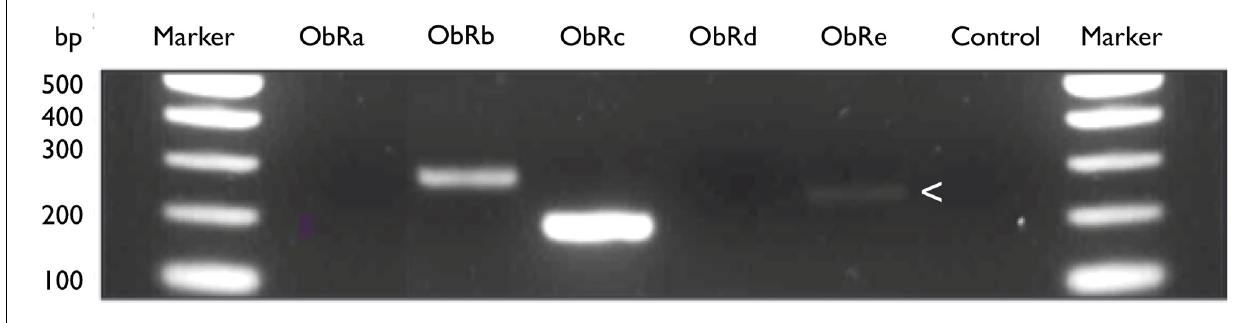
FIGURE 3 | LeptinR isoforms Ob-Rb, Rc, and Re by murine CD4 + T cells. Expression of leptinR isoforms by RT-PCR. CD4 + T cells were isolated and purified by negative selection from the MLN of H. pylori unvaccinated, infected female C57BL/6 mice. Equal amounts of